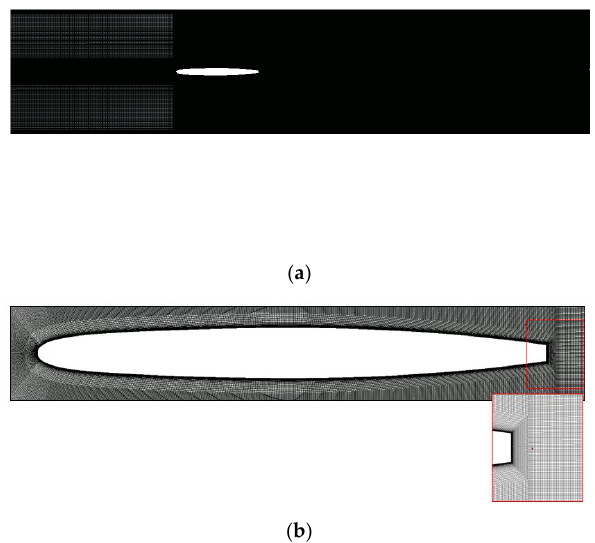
Figure 5. ( a ) Selected mesh for the entire fluid domain (N 1 ) and ( b ) detailed zooms showing the mesh topology around the hydrofoil surface and near the wake